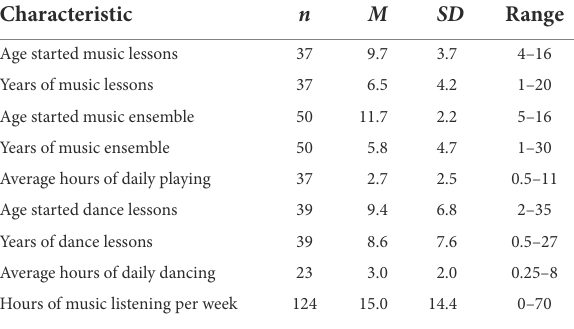
TABLE 2 Participants’ musical and dance experience: self-reported characteristics. Characteristic n M